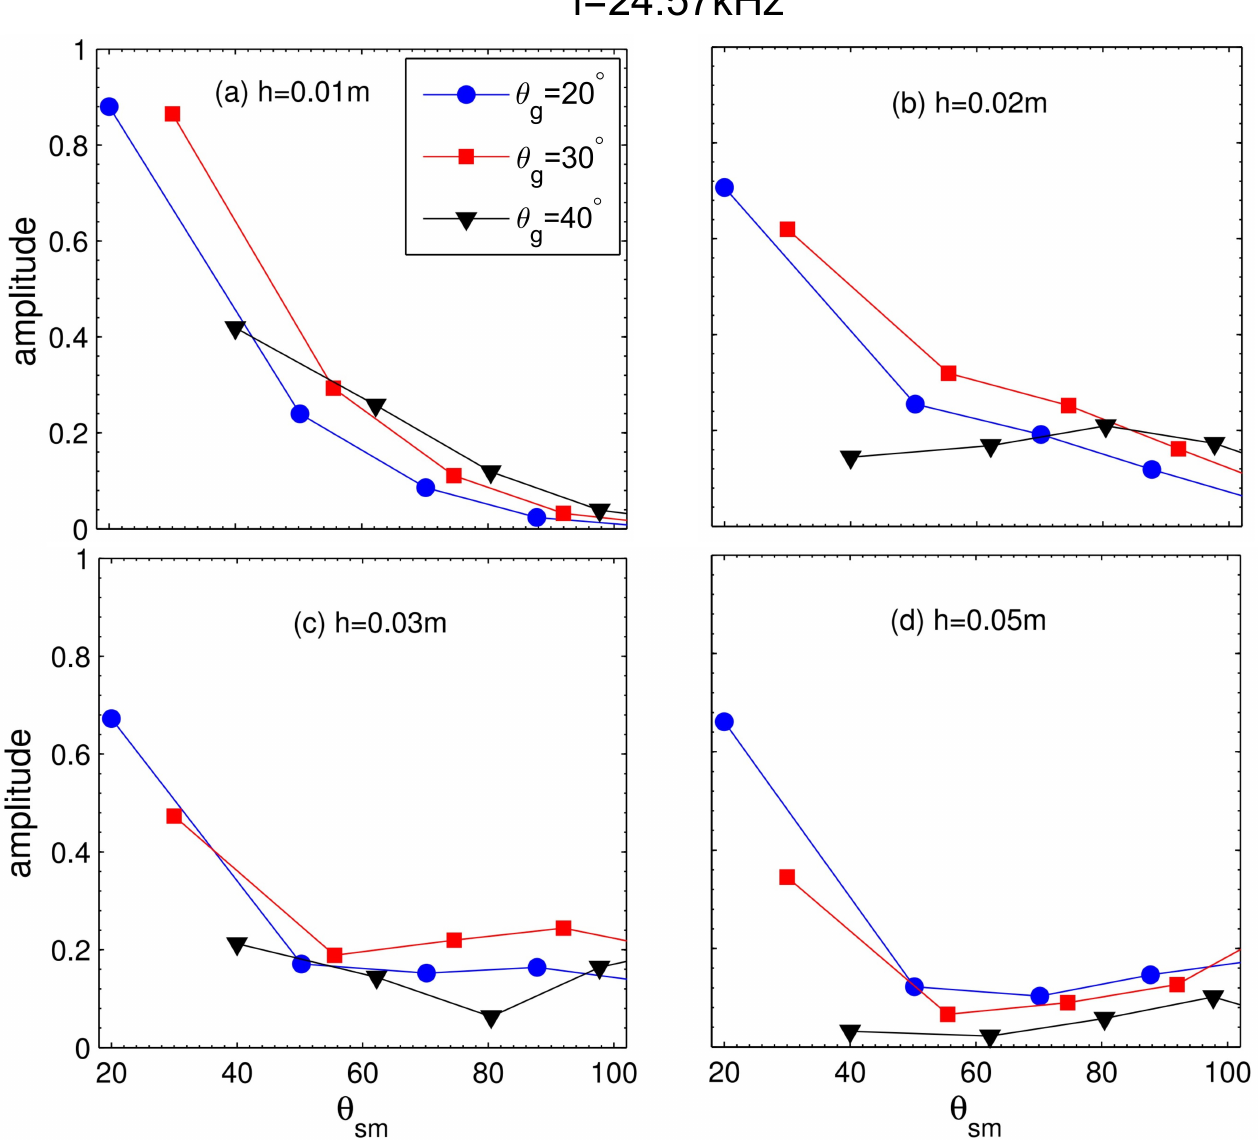
Figure 5. Dependence of the scattering amplitude on the scattered grazing angle θ sm at three dif- ferent incident grazing angles ( θ g = 20 ◦ ; 30 ◦ ; 40 ◦ ) for frequency f = 24.57 kHz. ( a ) h = 0.01 m; ( b ) h = 0.02 m; ( c ) h = 0.03 m; ( d ) h = 0.05